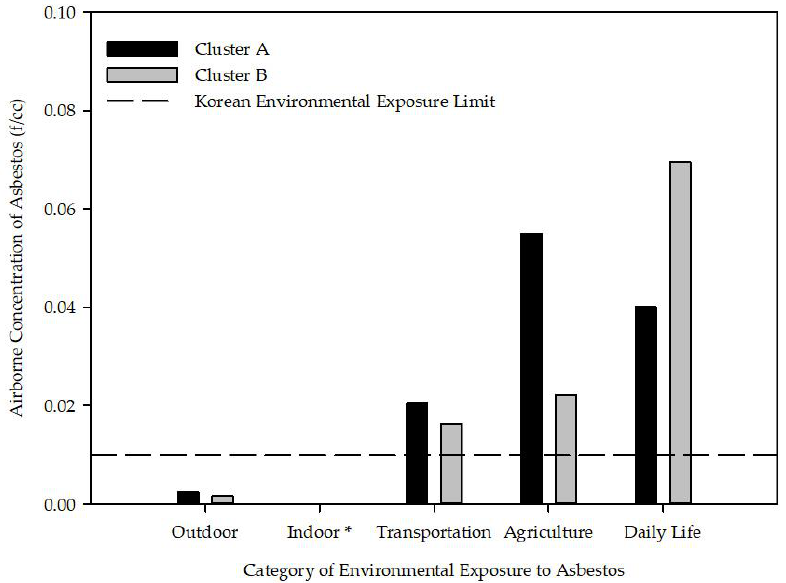
Figure 3. Airborne NOA concentrations of the abandoned asbestos mines in South Korea. * Airborne NOA concentration for indoor was too low to show in this figure (<0.0001 f/cc). Table 4. TWF and IUR based on survey results of residents near the abandoned asbestos mines in South